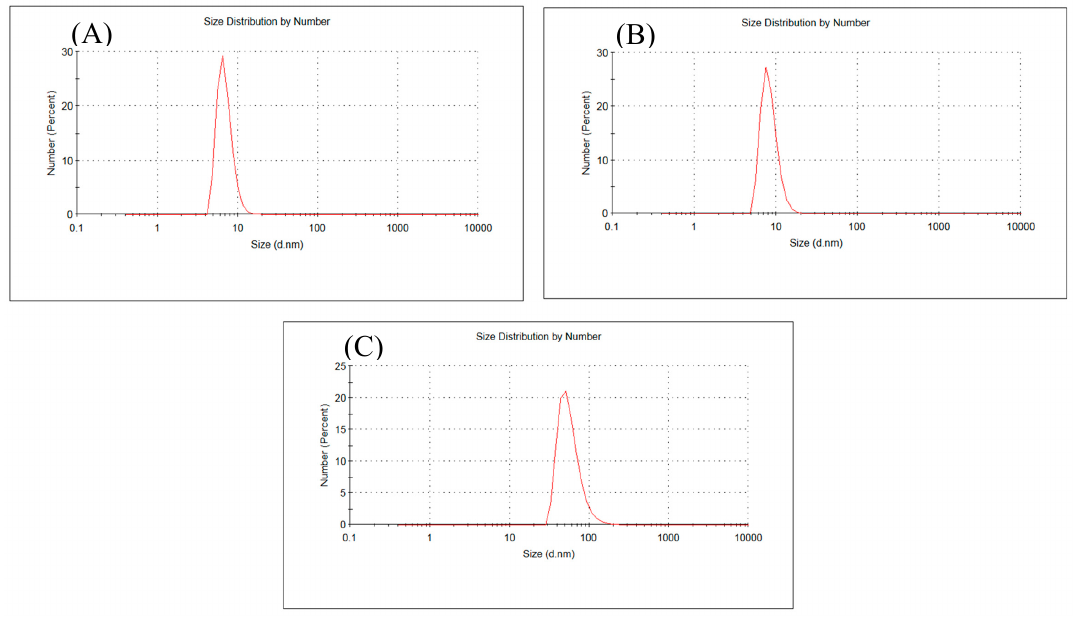
Figure 3. ( A – C ) DLS profile: Size distribution by number of AuNPs prepared using 0.25, 1.0, 3.5 mM HAuCl 4 , respectively.